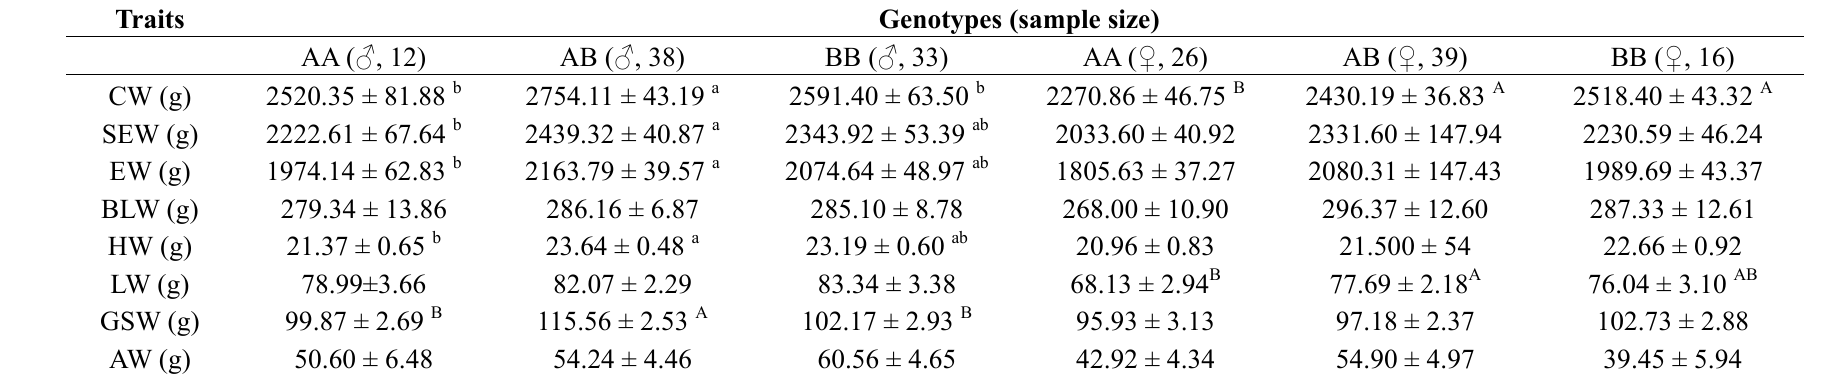
Table 3. Carcass traits of geese of different genotypes of exon 2 of the GH gene. Data represent the least-squares mean ± SD. CW, carcass weight; SEW, semi-eviscerated weight: EW, eviscerated weight; BLW, breast and leg muscle weight; HW, heart weight; LW, live weight; GSW, gland muscular stomach weight; AW, abdominal fat weight. a,b Means with different superscripts are significantly different ( p < 0.05). A,B Means with different superscripts are significantly different ( p < 0.01). ♂ , male population; ♀ , female